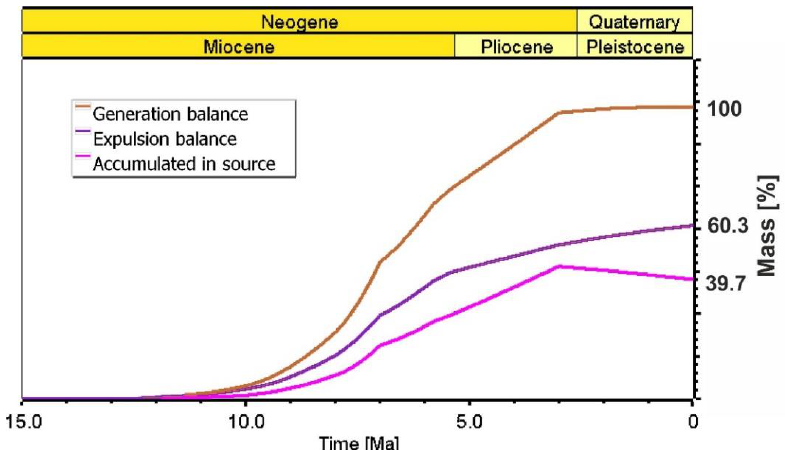
Figure 10. Dynamics of gas generation, expulsion, and accumulation processes within the source rocks of the analyzed part of Miocene basin, and proportion between generated, expelled, and accumulated masses of hydrocarbons.